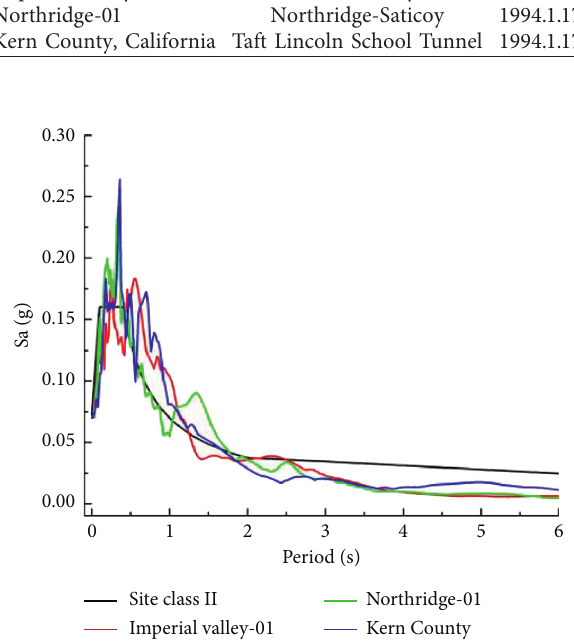
Figure 8: Acceleration response spectra of selected ground mo- tions and of code